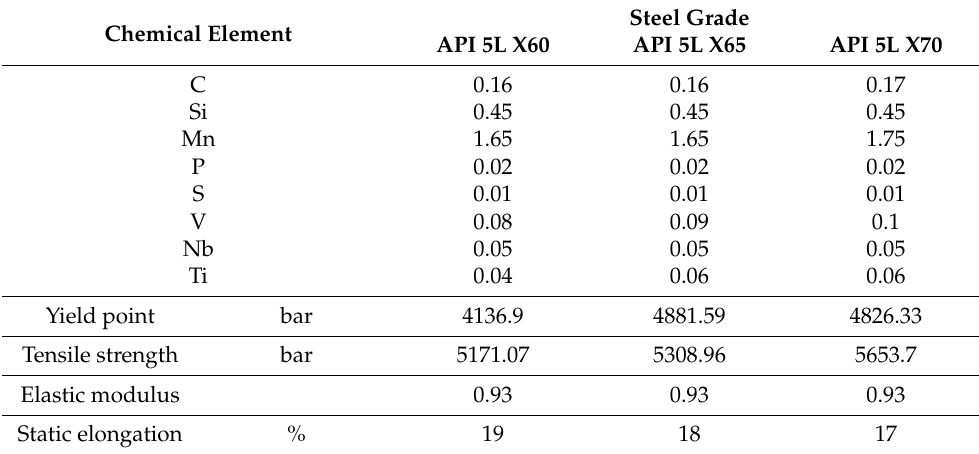
Table 2. Comparison of chemical composition and selected parameters of selected steel grades according to API